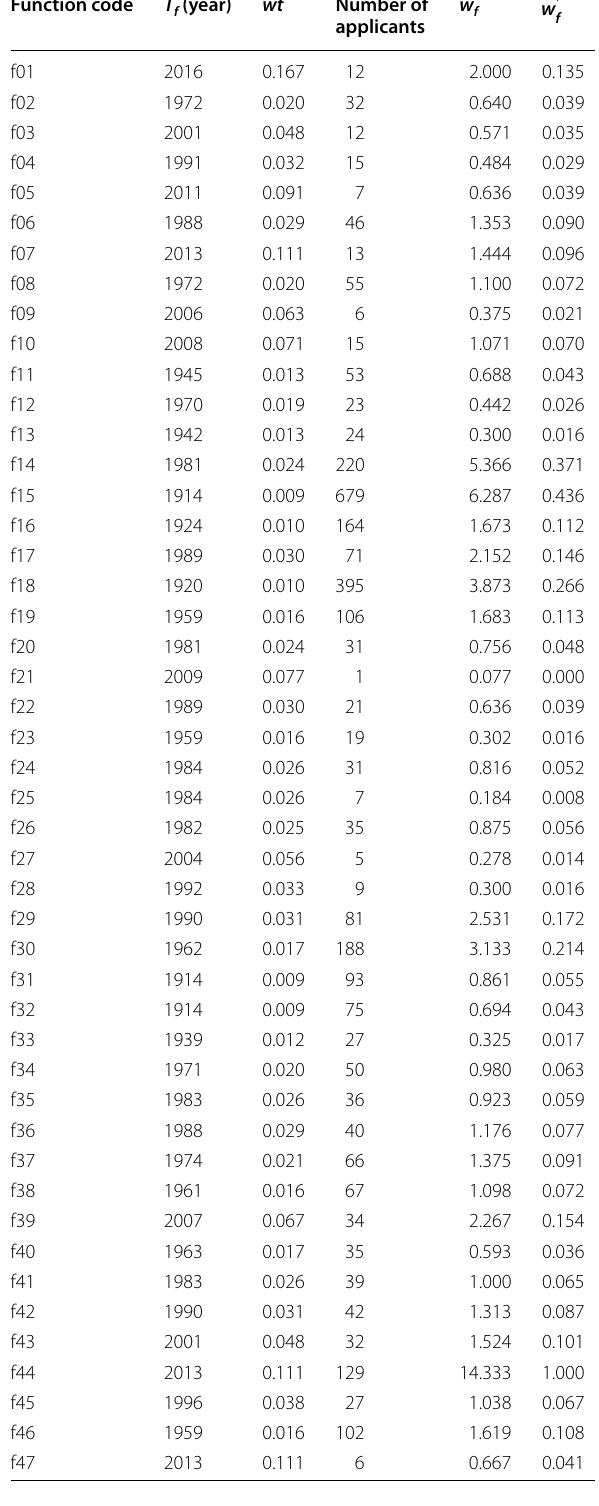
Table 4 Weight of function nodes in hypergraph Function